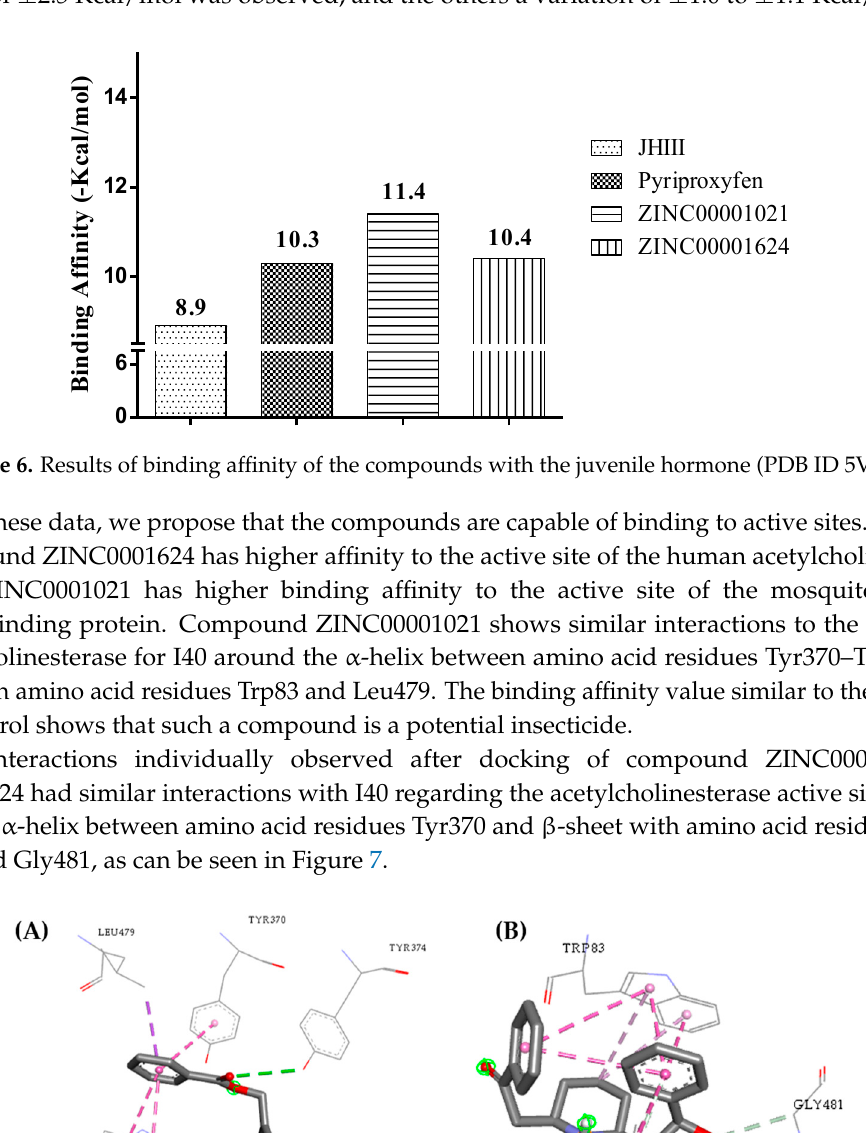
Figure 7 . Interactions between the acetylcholinesterase active site and the compounds ZINC00001021 ( A ) and ZINC00001624 ( B ).